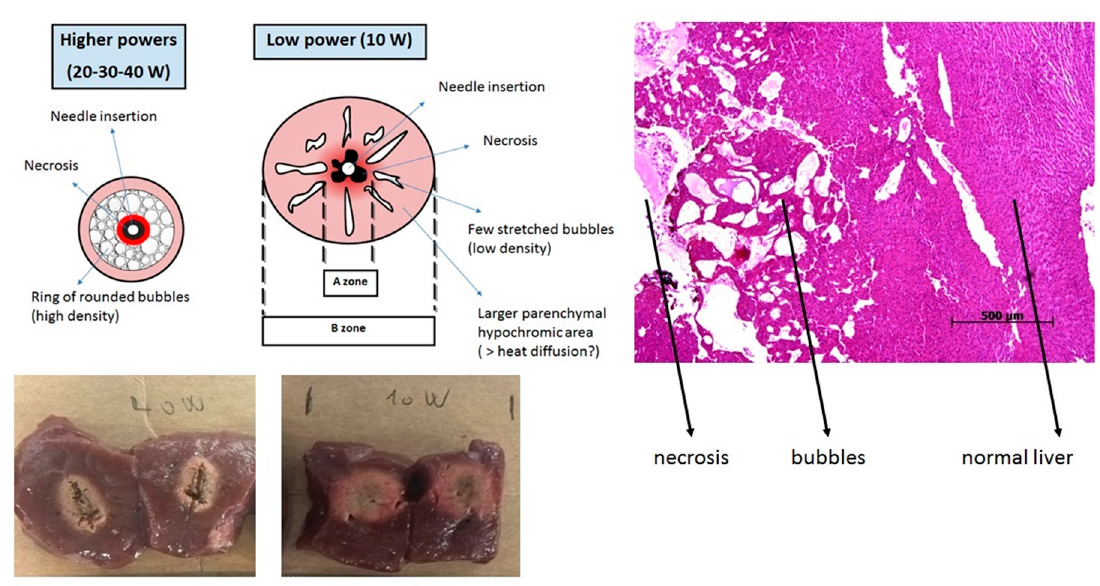
Figure 6. Macroscopic and histologic ablated areas aspect at di ff erent powers. Specimens in photos represent the macroscopic aspect of di ff erent ablation powers applied (see the di ff erences between higher (40 W) and lower (10 W) powers) and schematic drawings represent the histologic aspect of respective specimens at high (40 W) and low (10 W) powers. Hematoxylin and eosin staining on the tissue section shows the histologic aspect of the di ff erent zones obtained after the radiofrequency ablation (coagulative necrosis-air bubbles limiting the thermal ablation di ff usion and finally the external normal hepatic